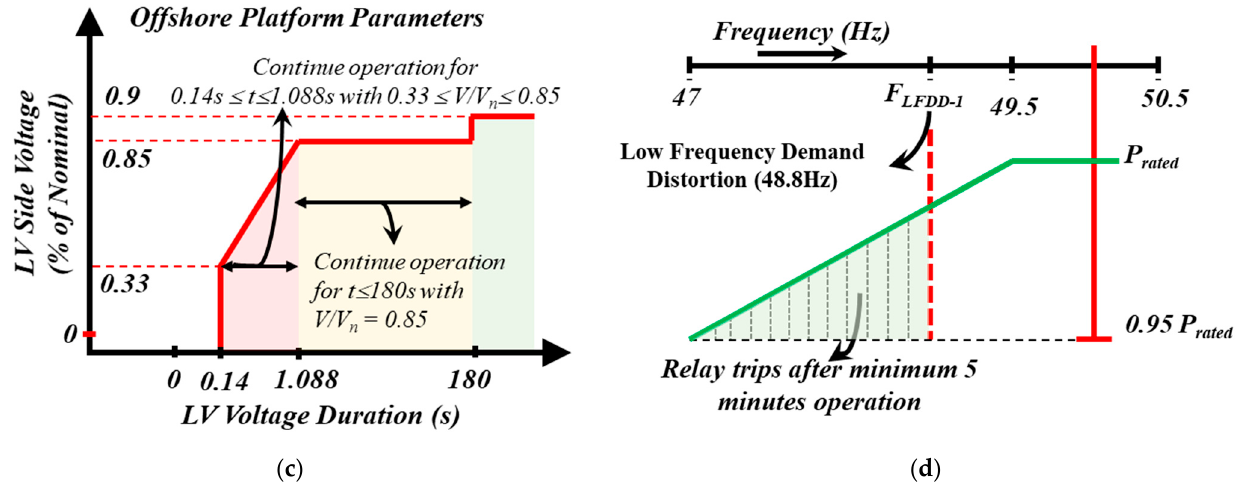
Figure 3. ( a ) Reactive power requirement as a function of active power to achieve wind farm integration in Great Britain [29]. ( b ) Requirement of withstanding voltage dips on the LV side of the offshore platform [28,29]. ( c ) Requirement of LV voltage sag duration requirement [28]. ( d ) Frequency requirement for wind farm integration in Great Britain [29].